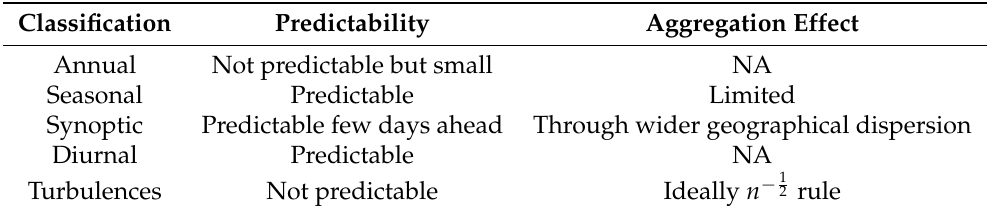
Table 2. Summary of temporal wind variations and their predictability, reproduced with permission from